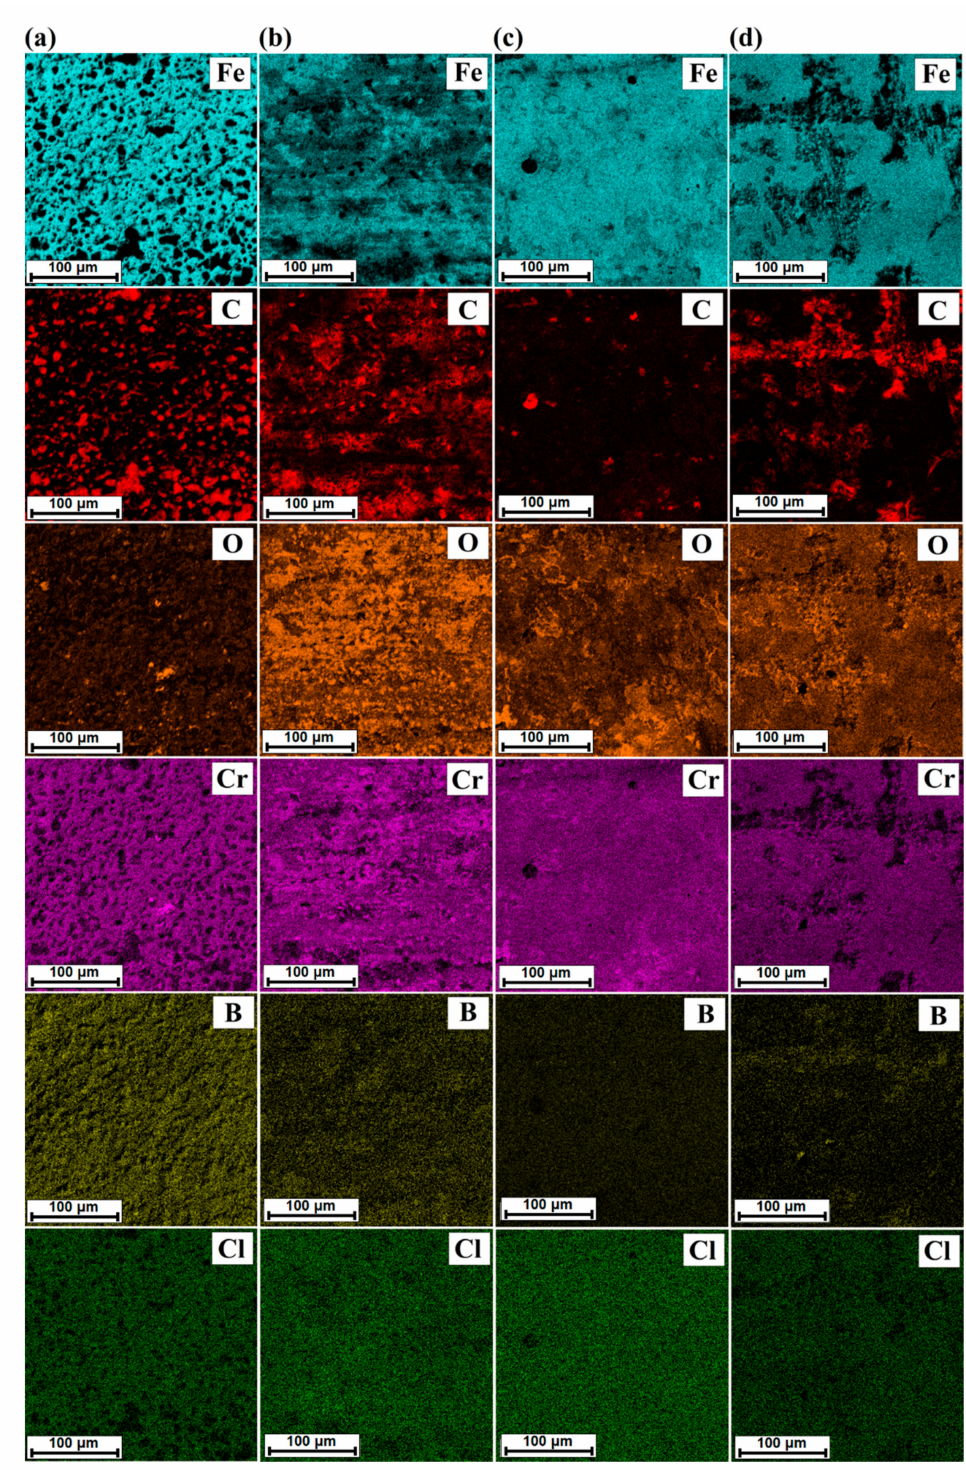
Figure 10. EDS map of surface condition after corrosion resistance test for ( a ) diffusion borochromized layer, ( b ) B-Cr coatings produced using 600 W, ( c ) B-Cr coatings produced using 900 W, and ( d ) B-Cr coatings produced using 1200